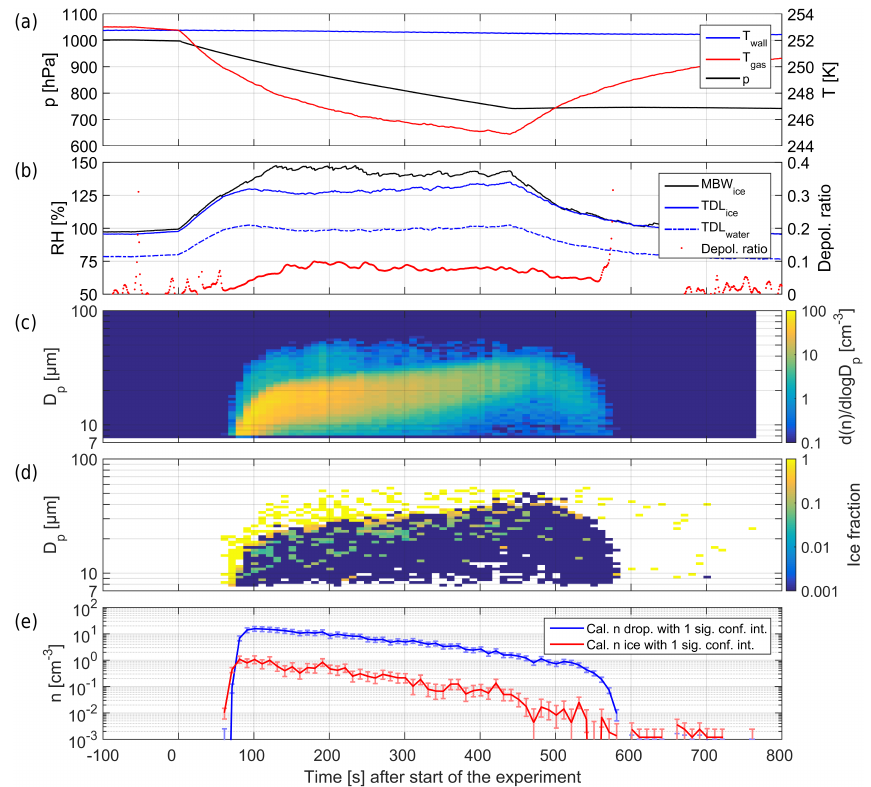
Figure 12. PPD-2K measurement, with t av = 10s, at the AIDA cloud chamber during RICE 03 campaign expansion run 46. (a) displays the pressure and the temperature in the AIDA vessel during the experiment. (b) is a plot of the relative humidity in the chamber as well as the depolarization ratio measured by the SIMONE instrument. (c) shows the number size distribution as measured by the PPD-2K. (d) displays a size-resolved ice fraction over the course of the experiment. The ice fraction is calculated from the numbers of observed ice and droplet patterns. In (e) the calculated droplet and ice number concentrations are